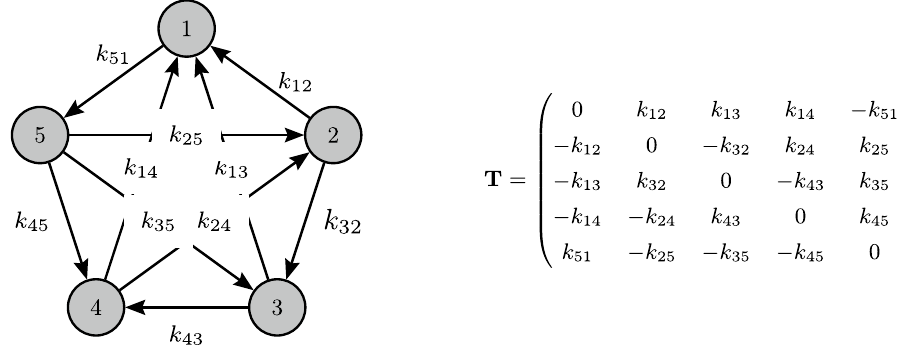
Figure 1. A 5-species tournament with corresponding tournament